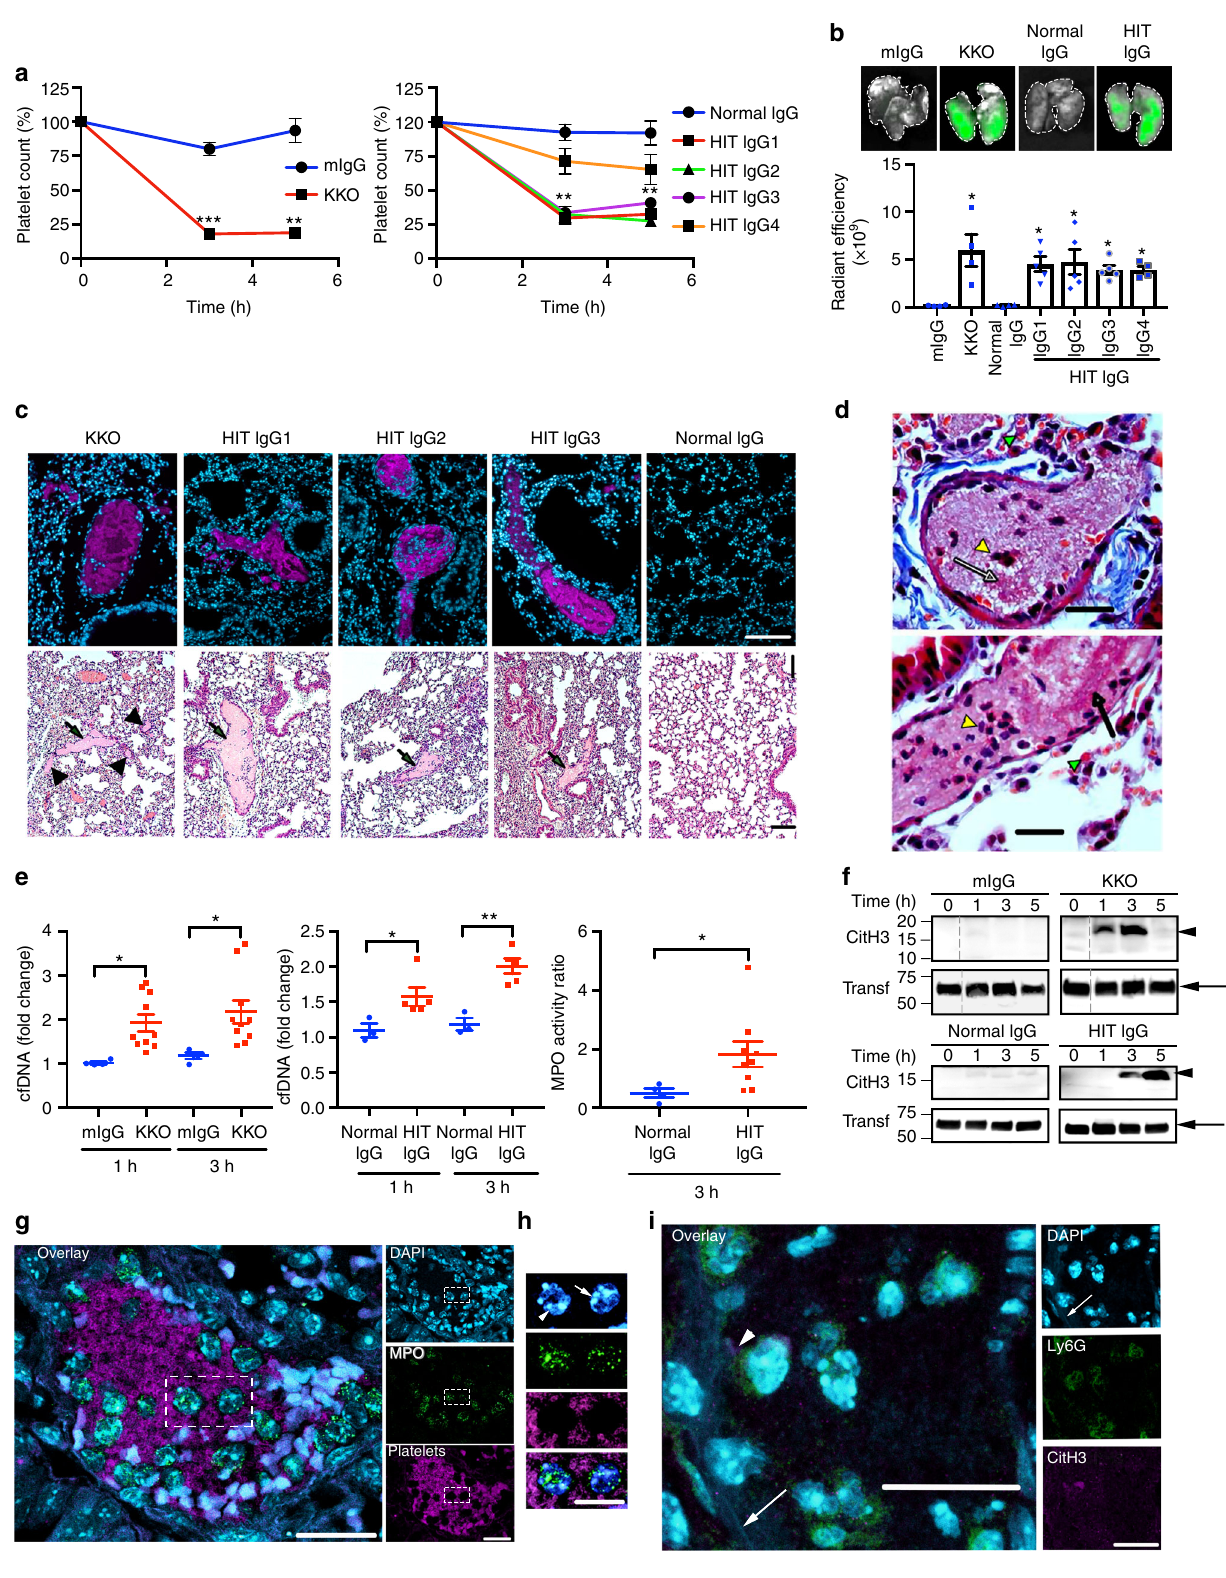
speci fi cally activate neutrophils and induce NETs formation. The imaging of neutrophils in the absence of platelets also released HIT immune complex associates with neutrophils via Fc γ RIIa extracellular DNA when incubated with HIT IgG, PF4 and since coincubation with the blocking antibody IV.3 prevents heparin in static conditions (Fig. 5a). No signi fi cant extracellular KKO – or HIT IgG – neutrophil association (Supplementary Fig. 7a, DNA release was detected when using normal IgG, PF4 and b). In static conditions, puri fi ed neutrophils and platelets released heparin (Fig. 5a, Supplementary Fig. 6 and Supplementary DNA after treatment with HIT IgG, PF4 and heparin, and this movies 7, 8), substantiating the previous fi nding that HIT ICs NATURE COMMUNICATIONS| (2019) 10:1322